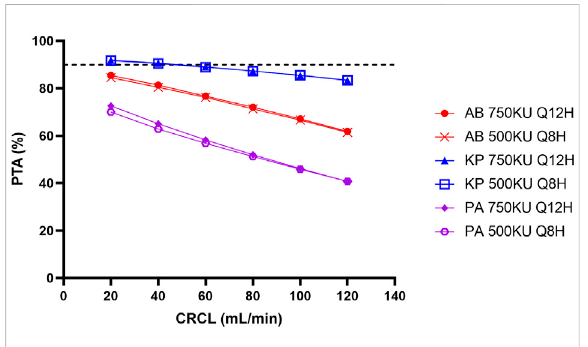
FIGURE 1 Simulated probability of achieving target attainment (PTA) of colistin sulfate at maximum daily dose for different micro- organisms. AB, Acinetobacter baumannii ; KP, Klebsiella pneumoniae ; PA, Pseudomonas aeruginosa ; CLCR, creatinine clearance